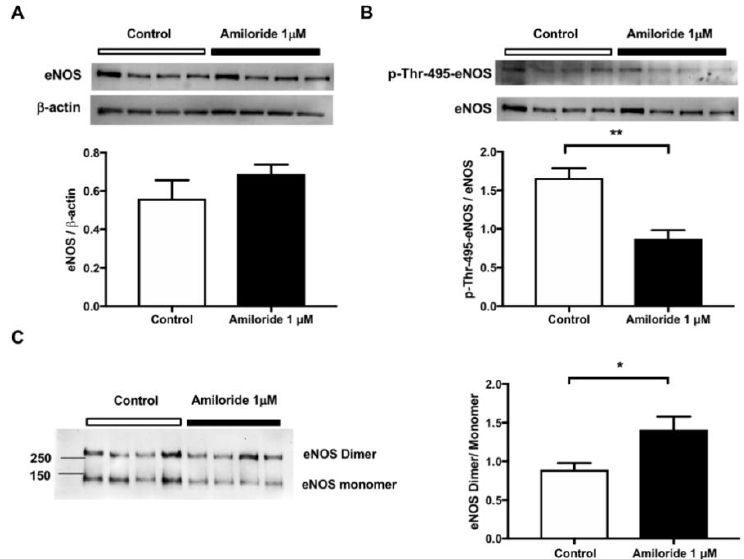
Figure 4. Pharmacological ENaC inhibition in human endothelial cells (HMEC-1) increases endothelial nitric oxide synthase (eNOS) activation/coupling . HMEC-1 cells were incubated with vehicle (control) or amiloride 1 μ M for 24 h. The ( A ) eNOS protein and ( B ) eNOS phosphorylation at threonine 495 levels were determined by Western blot. ( C ) The dimer/monomer ratio of eNOS was determined in low-temperature/low-voltage SDS electrophoresis and Western blot. n = 4 per group, each lane represents an independent experiment for each condition. * p < 0.05 and ** p < 0.01.